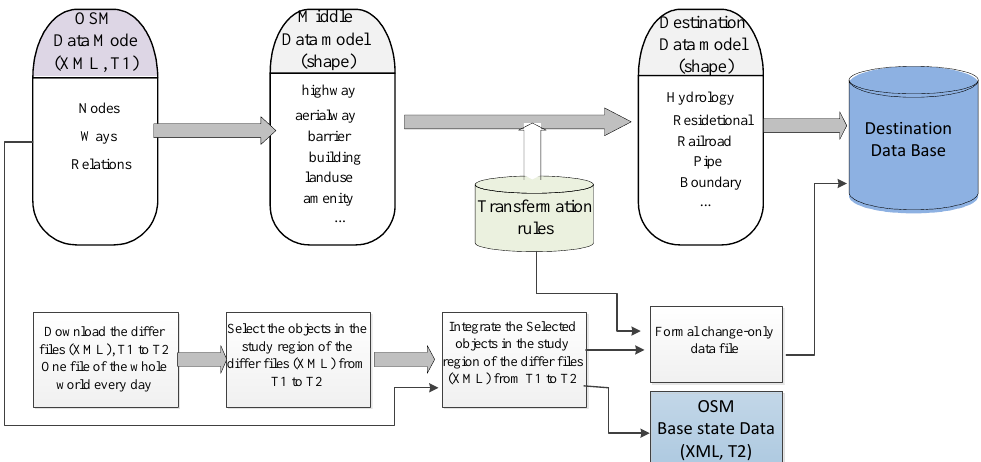
Figure 1. The strategy for dynamic integration of borderland database using OSM data